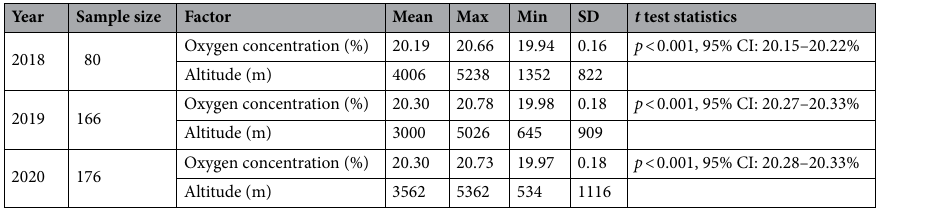
Table 1. Statistics of oxygen concentration and altitude of